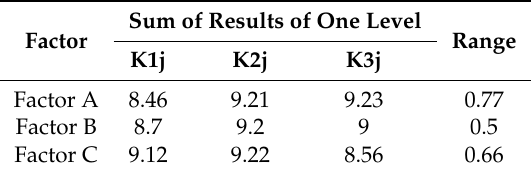
Table 7. Range analysis of orthogonal experiment of thickness as the target